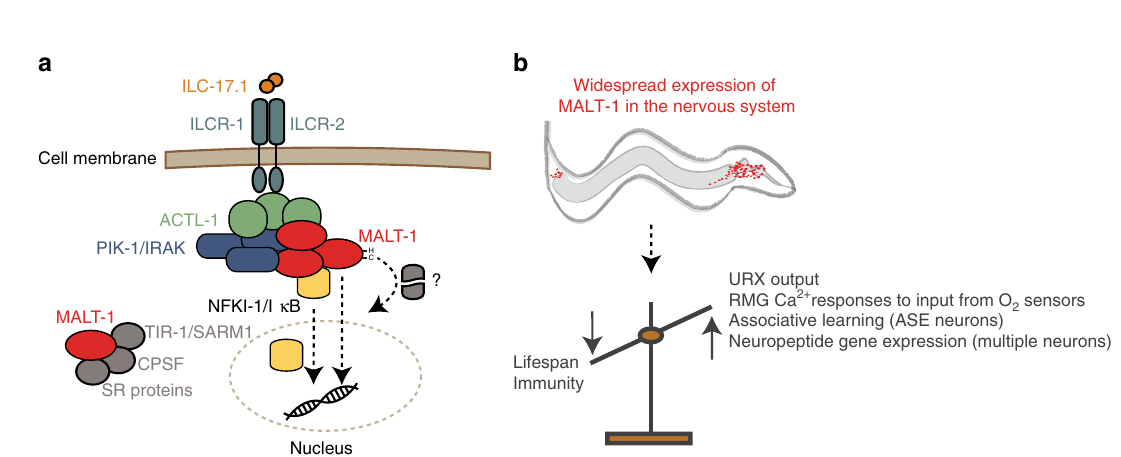
Fig. 8 MALT-1 acts downstream of IL-17 signaling to reprogram behavior and physiology. a and b Downregulated ( a ) and upregulated ( b ) genes in whole animal RNA-seq pro fi les of malt-1; npr-1, ilc-17.1; npr-1 and nfki-1; npr-1 double mutants compared to npr-1 controls. Gene ontology (GO) terms and KEGG pathways signi fi cantly overrepresented among genes dysregulated in all three mutant conditions are shown ( q -value <0.05, with a minimum log2 (fold-change) of ±0.25). c and d Salt chemotaxis after conditioning by food-withdrawal in the absence or presence of NaCl. * P < 0.05, ** P < 0.01, *** P < 0.001, one-way ANOVA with Tukey ’ s post hoc HSD, N = 6 assays. d The salt chemotaxis learning defect of ilcr-1 mutants is rescued by driving ilcr-1 expression in many neurons ( rab-3 or fl p-21 promoters), or speci fi cally in ASE ( fl p-6 promoter). e – i PA14 big lawn assays. n ≥ 81 animals. *** P < 0.001, two- sided logrank test; precise n numbers and P values are provided in Supplementary Table 1. Mutants lacking malt-1 ( e ) or encoding protease-dead malt-1 ( f ), or defective in other IL-17 signaling components ( g, h ) are resistant to P. aeruginosa PA14 in big lawn assays, where animals cannot escape from the PA14 lawn. The enhanced survival of malt-1 mutants is rescued by pan-neuronal expression of malt-1 gDNA. n ≥ 81 animals. i The enhanced resistance of malt-1 mutants to PA14 requires TIR-1. Like tir-1 mutants, malt-1; tir-1 double mutants are hypersensitive to PA14 infection. j – m Lifespan. n ≥ 92 animals. ** P < 0.01, *** P < 0.001, two-sided logrank test; precise n numbers and P values are provided in Supplementary Table 3. j and k The lifespan of malt-1 and ilc-17.1 mutants is increased compared to N2 controls. The malt-1 phenotype is rescued by expressing malt-1 gDNA pan-neuronally ( j ) and the ilc-17.1 phenotype can be rescued by expressing ilc-17.1 cDNA from its endogenous promoter ( k ). l The lifespan phenotypes of malt-1 and ilc-17.1 mutants are not additive. m The shortened lifespan of animals overexpressing ILC-17.1 is abolished in malt-1 mutants. See also Supplementary Fig. 7, Supplementary Tables 1 – 3 and